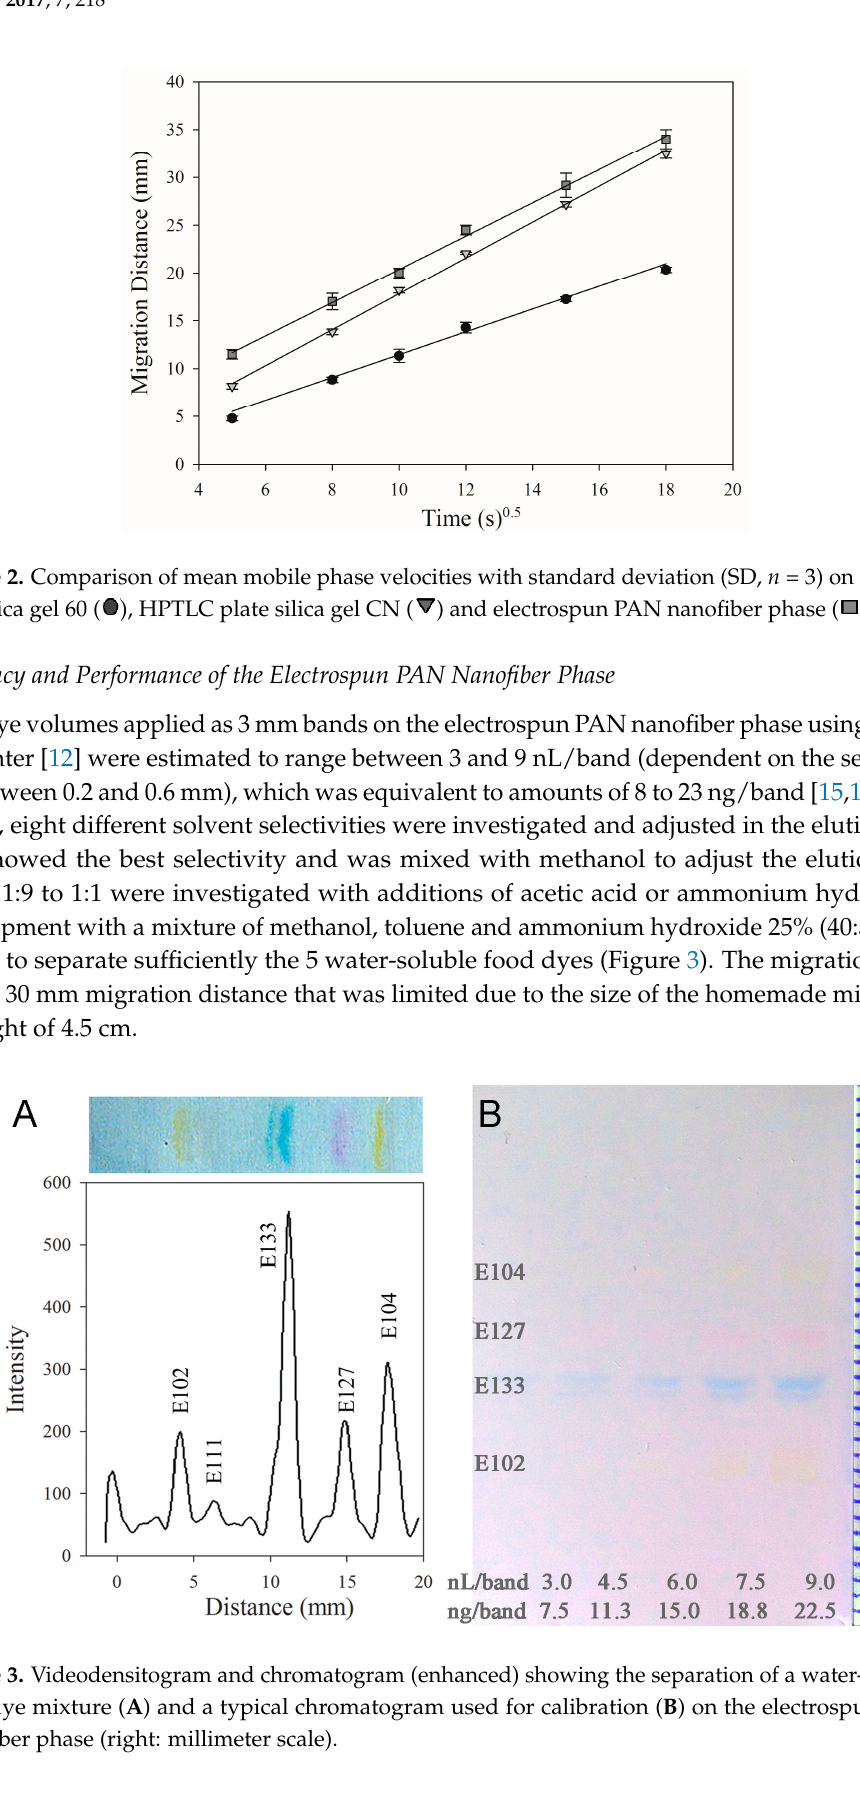
Figure 3. Videodensitogram and chromatogram (enhanced) showing the separation of a water-soluble food dye mixture ( A ) and a typical chromatogram used for calibration ( B ) on the electrospun PAN nanofiber phase (right: millimeter scale).